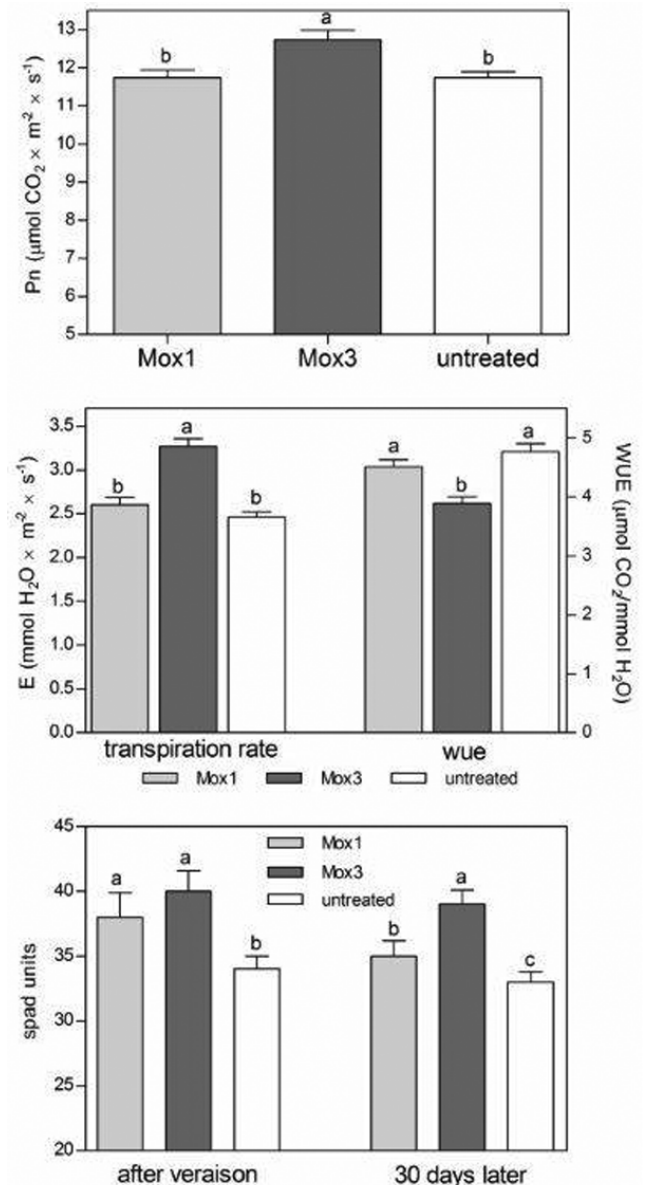
Fig. 3 - Top: assimilation rates measured after veraison in Mo-treated and untreated grapevine plants. Middle: transpiration rates and water use efficiency measured after veraison in Mo-treated and untreated grapevine plants. Bottom: SPAD units measured after veraison and a month later in Mo-treated and untreated grapevine plants. Error bars reflect the LSD at p ≤ 0.05. Dif- ferent letters correspond to significant differences (p ≤ 0.05). Mox1= Mo treatment in early flowering; Mox3= Mo treat- ments in early flowering, early fruit set and early veraison.